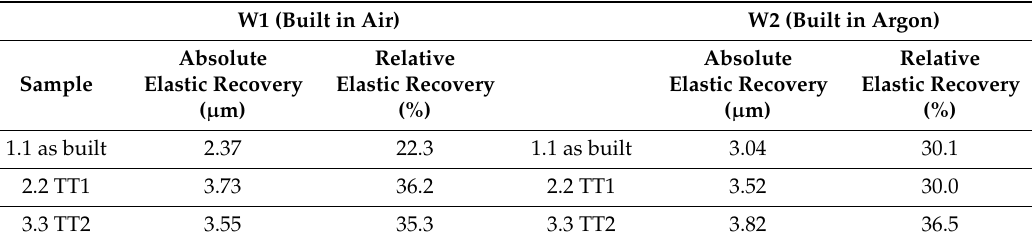
Table 6. Elastic recovery values employing a load of 1 N.